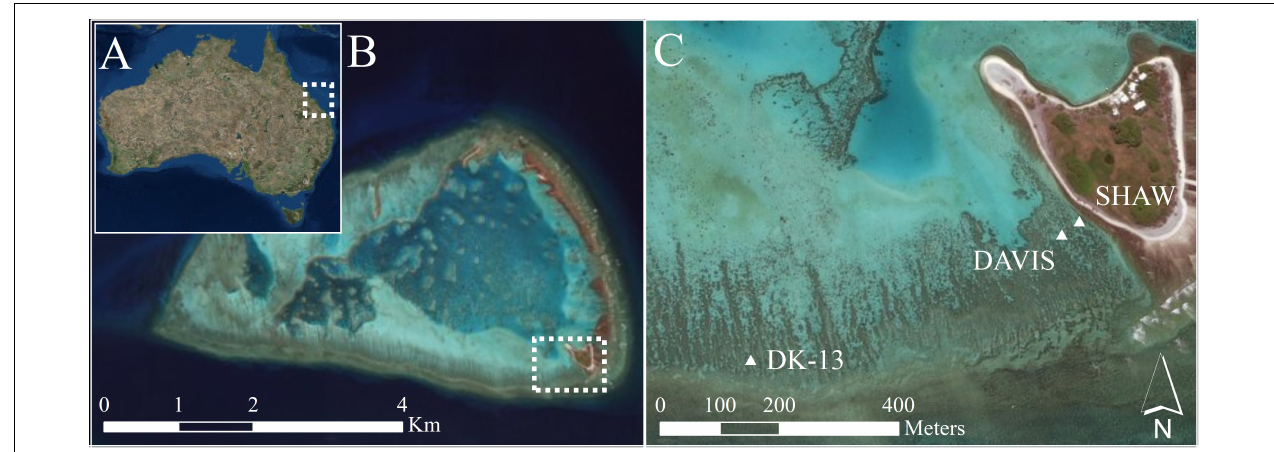
FIGURE 1 | (A) Map of Australia with white dotted square representing the Capricorn Bunker Group of the Southern GBR, (B) One Tree Island coral cay and lagoon with white dotted rectangle denoting area of sampling, and (C) sampling locations used in this